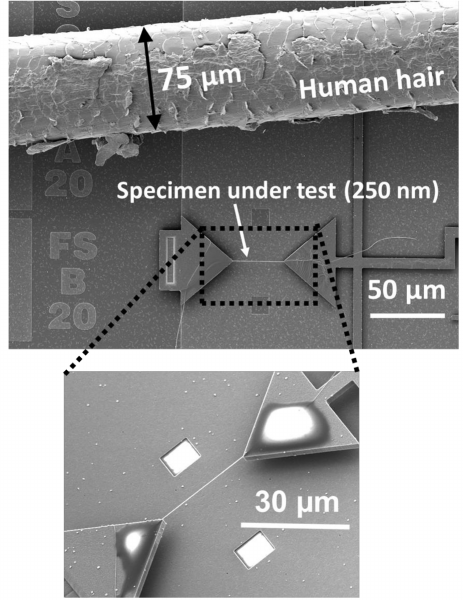
Figure 8. SEM image of a 250 nm diameter NF in comparison with human hair. Inset: detailed view of gripped